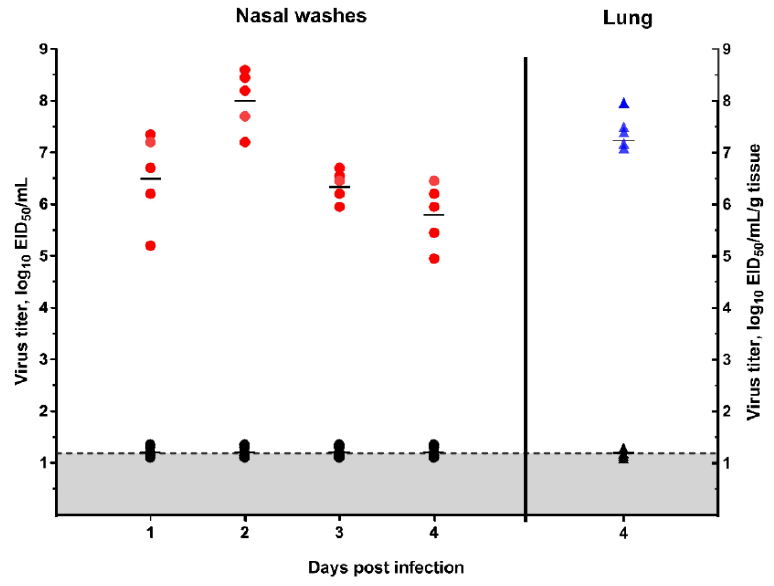
Figure 5. Virus replication in the lungs and upper respiratory tract of the ferrets as measured by titration in embryonated chicken eggs (mean ± SD).